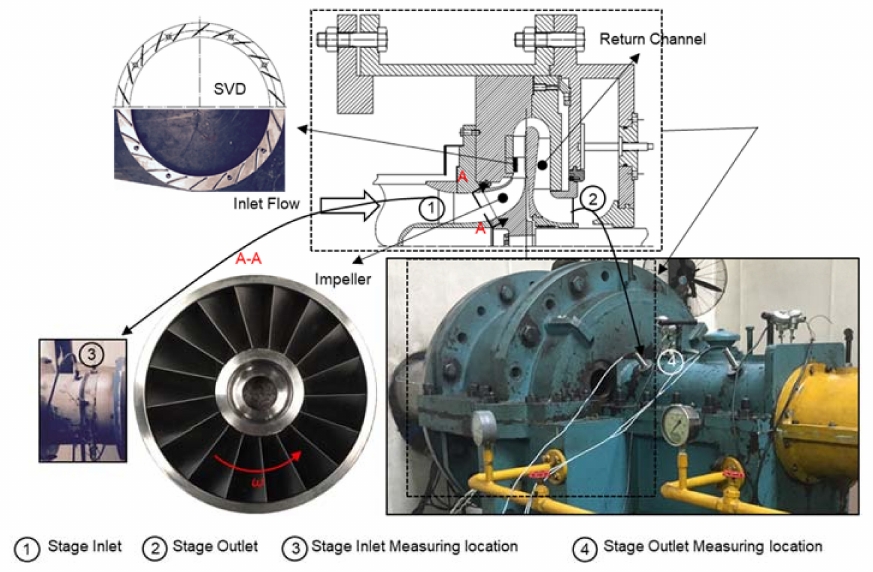
Figure 4. Schematic sketch of the test rig.